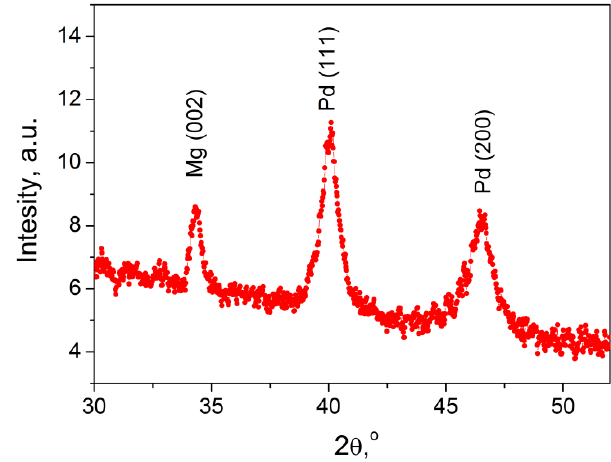
Figure 7. XRD scan of the Mg(50 nm)/Ta(10 nm)/Pd(20 nm) film, taken at room temperature using Cu K α 1